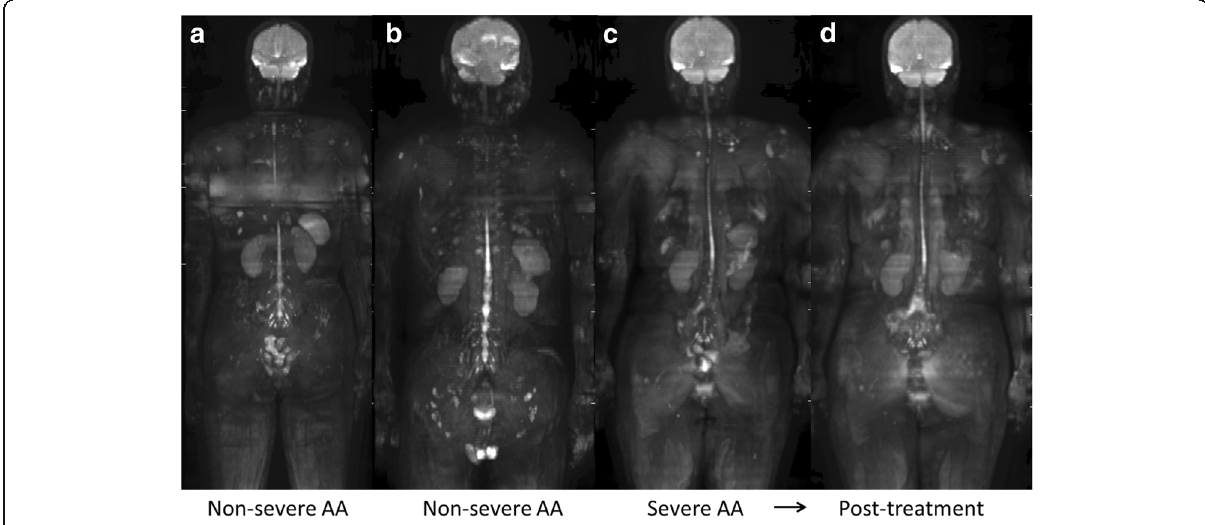
Fig. 4 Maximum intensity projection DWI images of AA patients ( a – d ). a – d in Fig. 4 are identical to a – d in Fig. 3, respectively. Whole-body